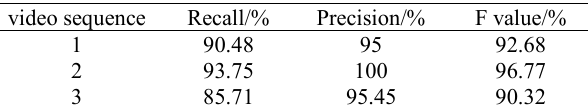
Table 4 . Traffic video test results.